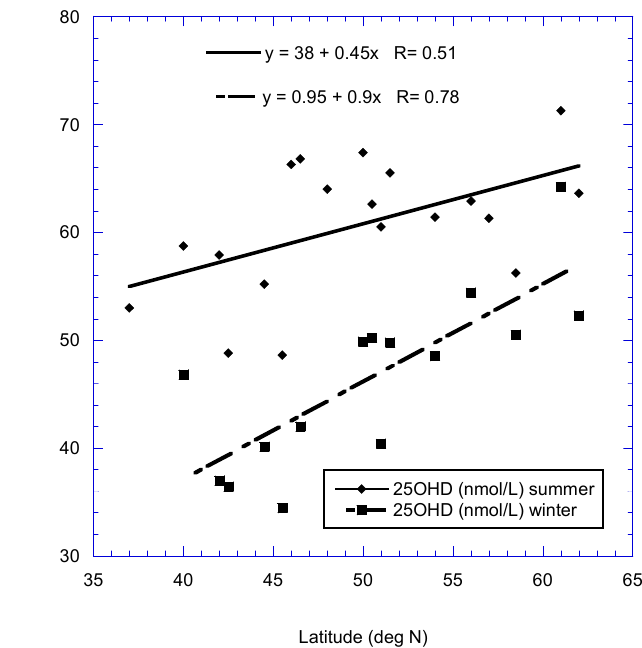
Figure 1. Serum 25(OH)D concentrations for females in 11 countries vs. energy supply from ocean fish (Portugal is omitted) (Table 2).